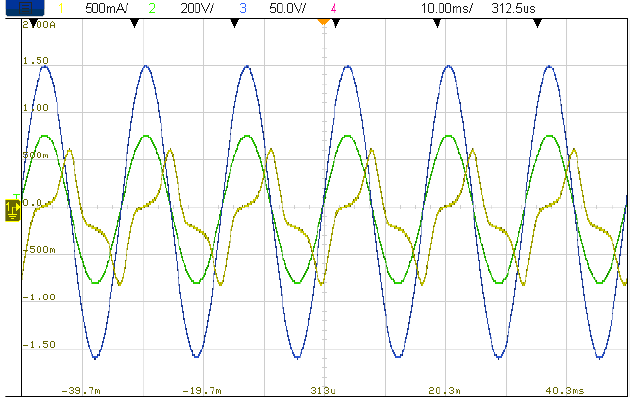
Figure 6. Circuit diagram without an integrator, in which ch1 (yellow) is the current on the low- voltage side of the transformer, ch2 (green) is the voltage on the high-voltage of the transformer, and ch3 (blue) is the voltage on the low-voltage of the transformer.